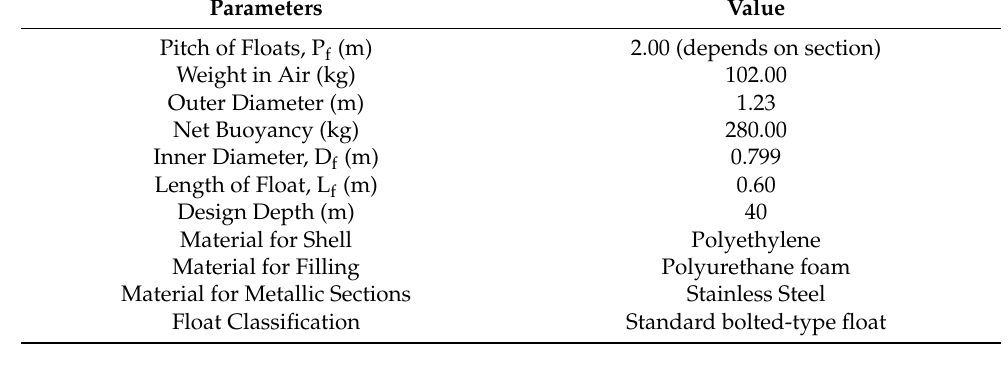
Figure 8. The Cartesian Coordinate System showing the Buoy and Mooring Lines in ( a ) top view ( b ) side view .